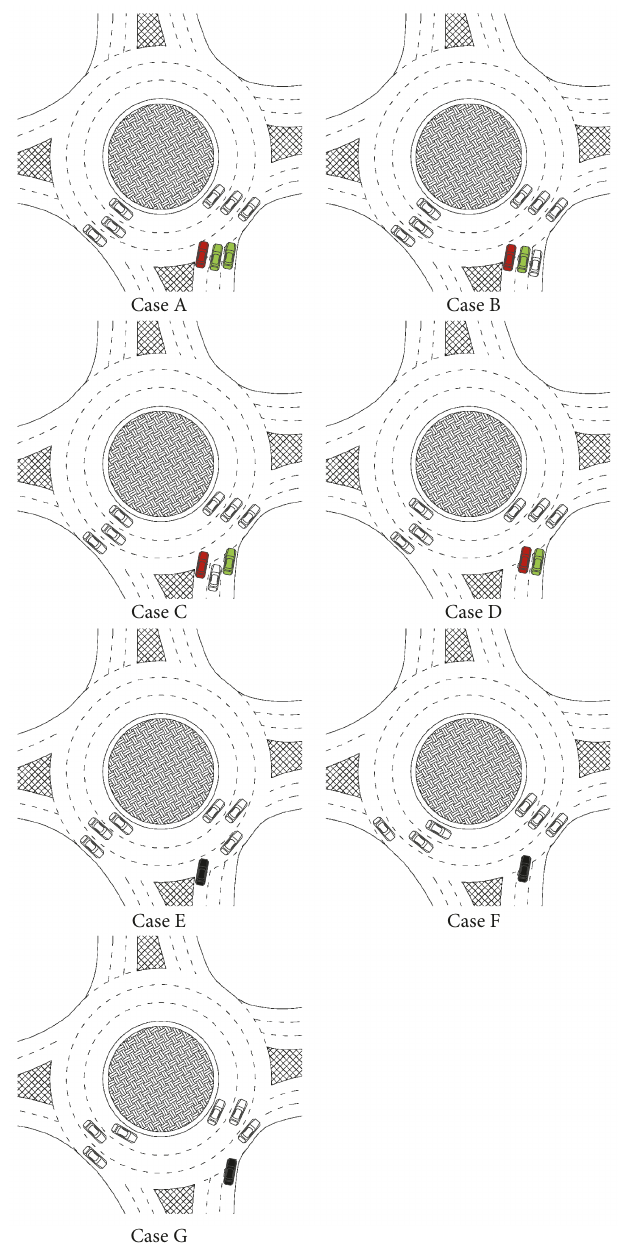
Figure 4: Interaction cases based on group gap